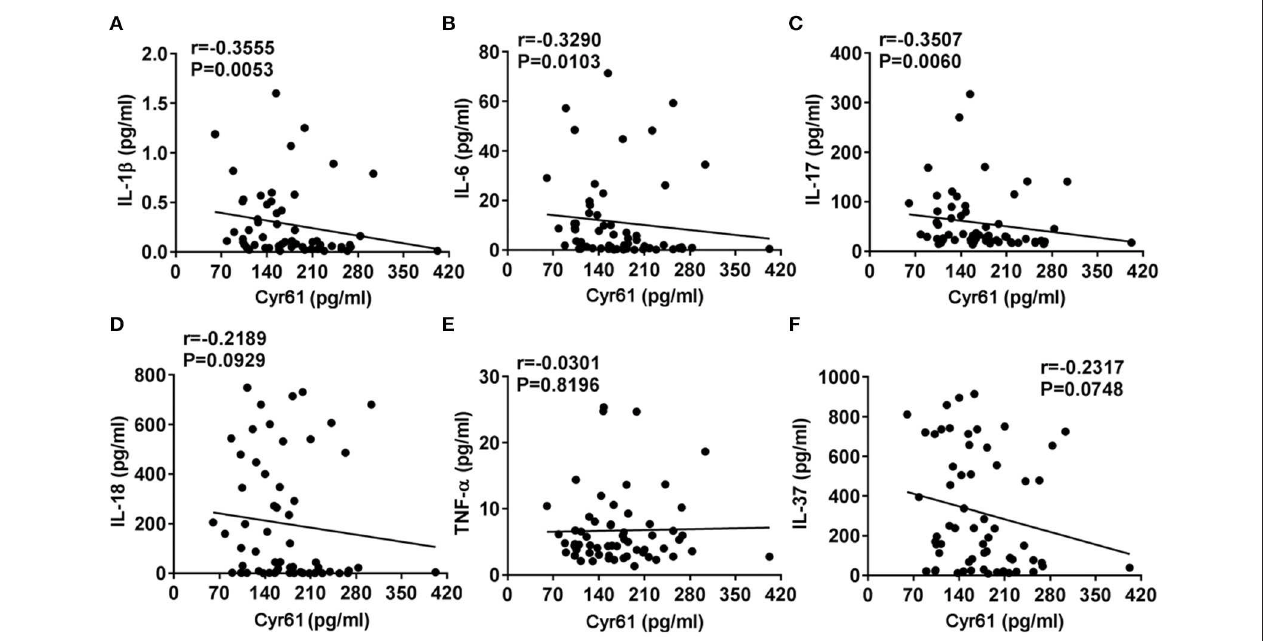
FIGURE 4 | The correlations between the serum levels of Cyr61 and inflammatory cytokines in adult-onset Still’s disease (AOSD) patients are shown. The associations between the serum levels of Cyr61 and interleukin (IL)-1 β (A) , IL-6 (B) , IL-17 (C) , IL-18 (D) , tumor necrosis factor (TNF)- α (E) , and IL-37 (F) were analyzed by the non-parametric Spearman correlation